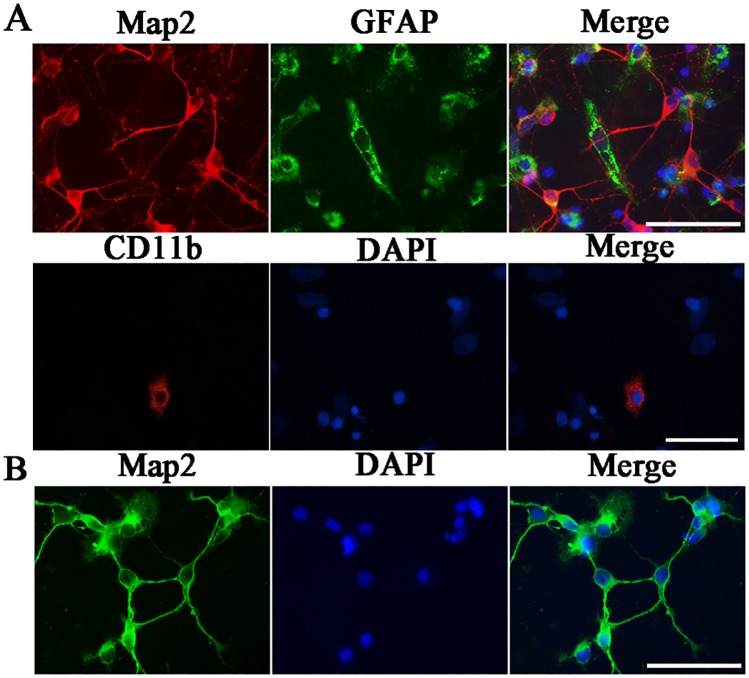
Cell compositions in the mixed cultures and retinal neuron cultures.(A) Double immunofluorescence Map2/GFAP, CD11b/DAPI staining in mixed cultures. (B) Double immunofluorescence Map2/DAPI staining in retinal neuron cultures. Scale bar = 50 μm.